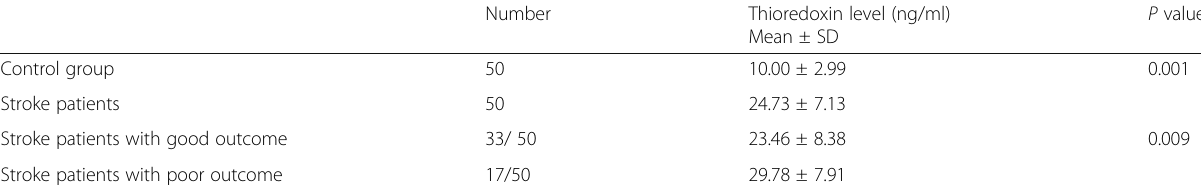
Table 2 Thioredoxin level in different clinical situations